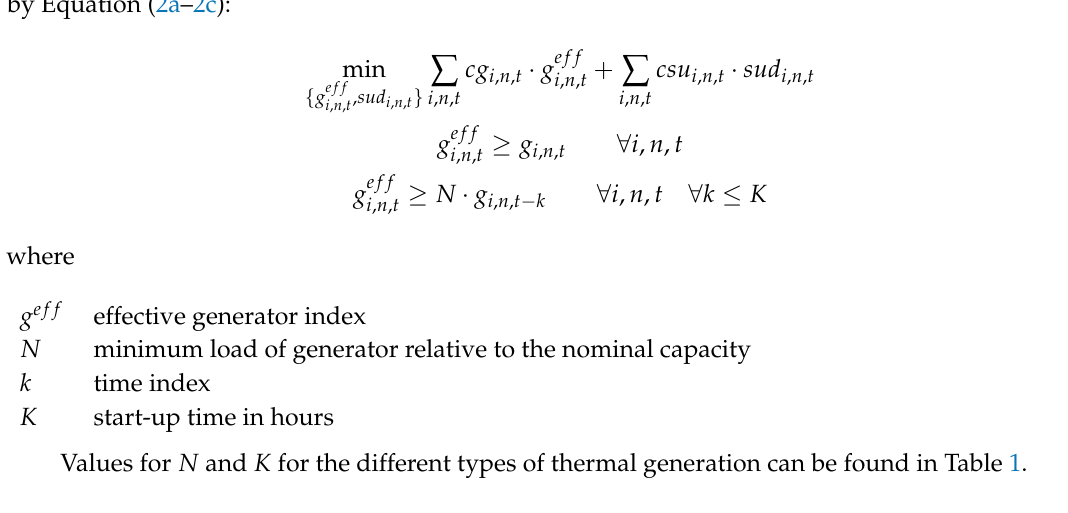
Table 1. Modeling parameters of thermal generation for the linear unit commitment approximation